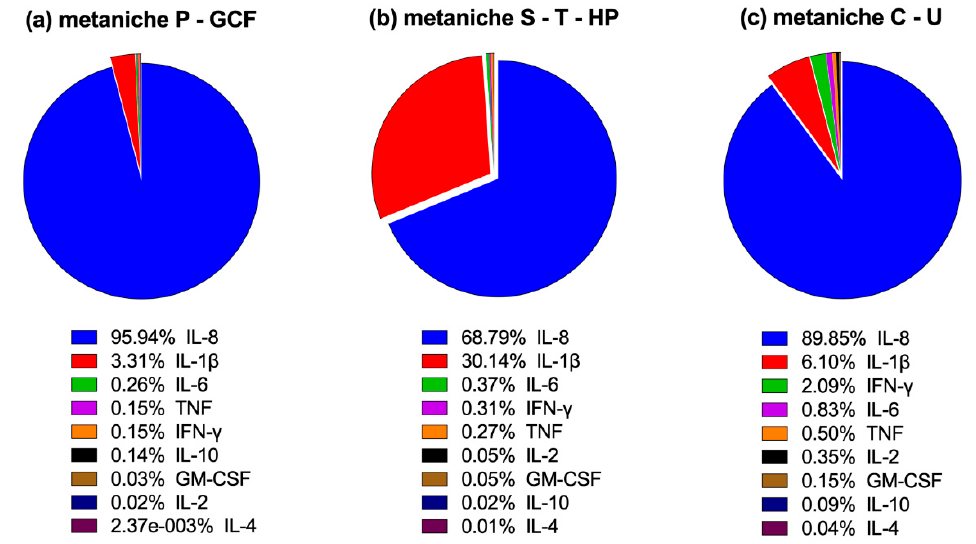
Figure 5. Relative quantities of cytokines in the defined microbial metaniches P-GCF, S-T-HP and C-U are given as a percentage of the total cytokine level measured. ( a ) metaniche P-GCF, ( b ) metaniche S-T-HP and ( c ) metaniche C-U.